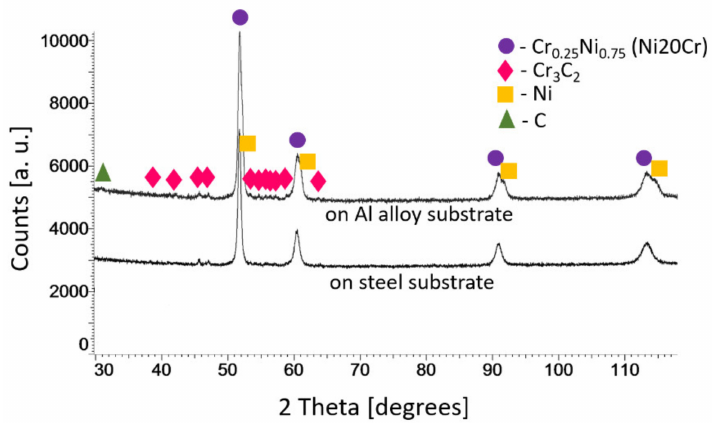
Figure 3. X-ray diffraction patterns for the (Cr 3 C 2 -25(Ni20Cr))-(Ni25C) coatings deposited on the Al 7075 alloy and 1H18N9T steel